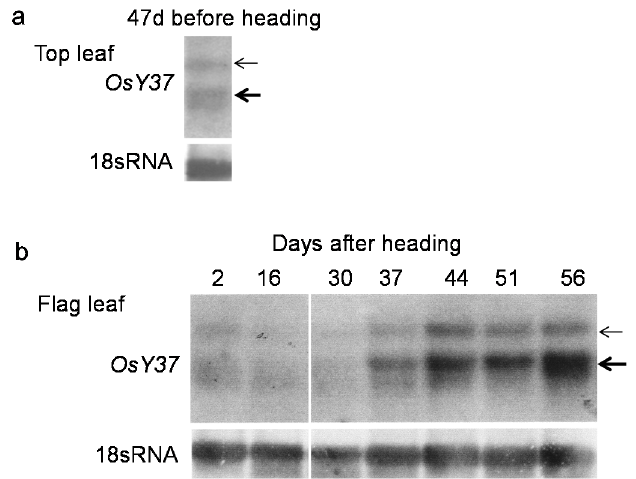
Figure 1. Northern hybridization analysis of OsY37 gene transcript accumulation during leaf senescence. Rice cv. “Akitakomachi” top leaves were harvested at 47 d before heading ( a ) and flag leaves after heading dates ( b ). Total RNA was extracted from the leaves of several plants at the same growth stages. RNA (20 µg) was separated by agarose/formaldehyde gel electrophoresis, blotted onto a nylon membrane, and allowed to hybridize with the [ α - 32 P]-dCTP-labeled 251 bp OsY37 I segment (Figure S2). Thick and thin arrows point to 1 and 3–4 kb transcripts, respectively. The same membrane was re-hybridized with cDNA of Arabidopsis thaliana 18S rRNA as a loading control, which is shown below the OsY37 I segment-probed hybridization. After hybridization, the membrane was washed under high stringency washing conditions.